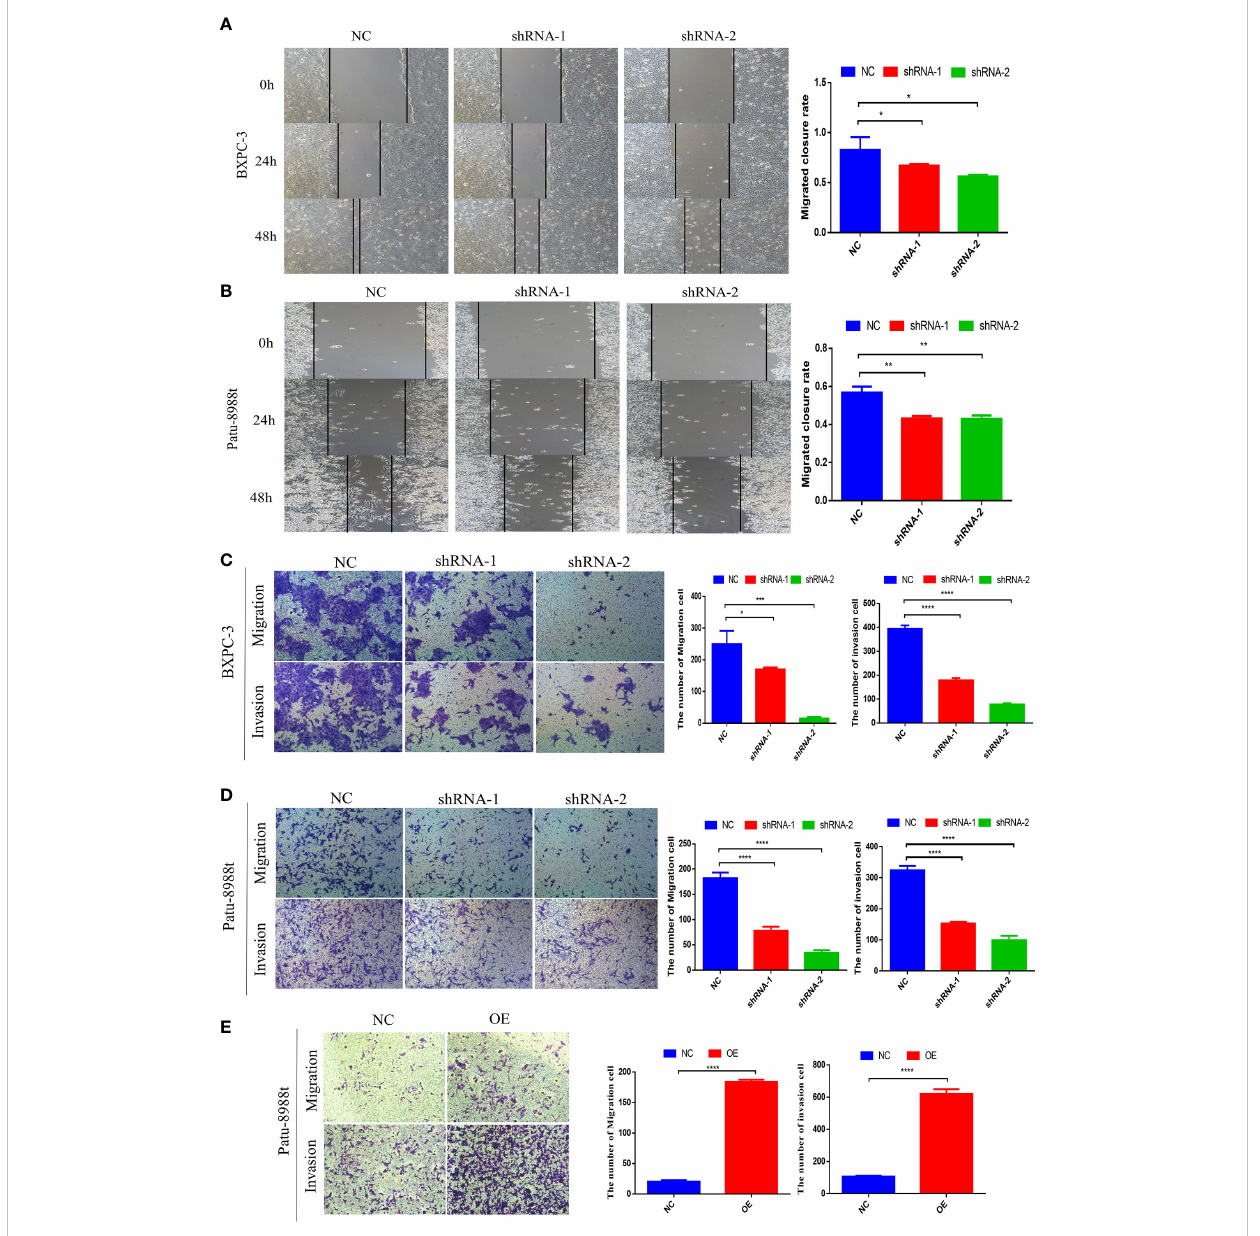
FIGURE 3 GALNT6 promotes the biological functions of PDAC cells. (A, B) Cell migration was detected by wound healing assay. (C, D) Transwell was used to detect the migration and invasion of Patu-8988t and BXPC-3 cells of GALNT6 knockdown. (E) Transwell assay was used to detect the migration and invasion of Patu-8988t cells of overexpression GALNT6. Each experiment was repeated at least three times independently, and the experimental data were expressed as mean standard deviation (X ± SD). *p <0.05; **p <0.01; ***p <0.001; ****p